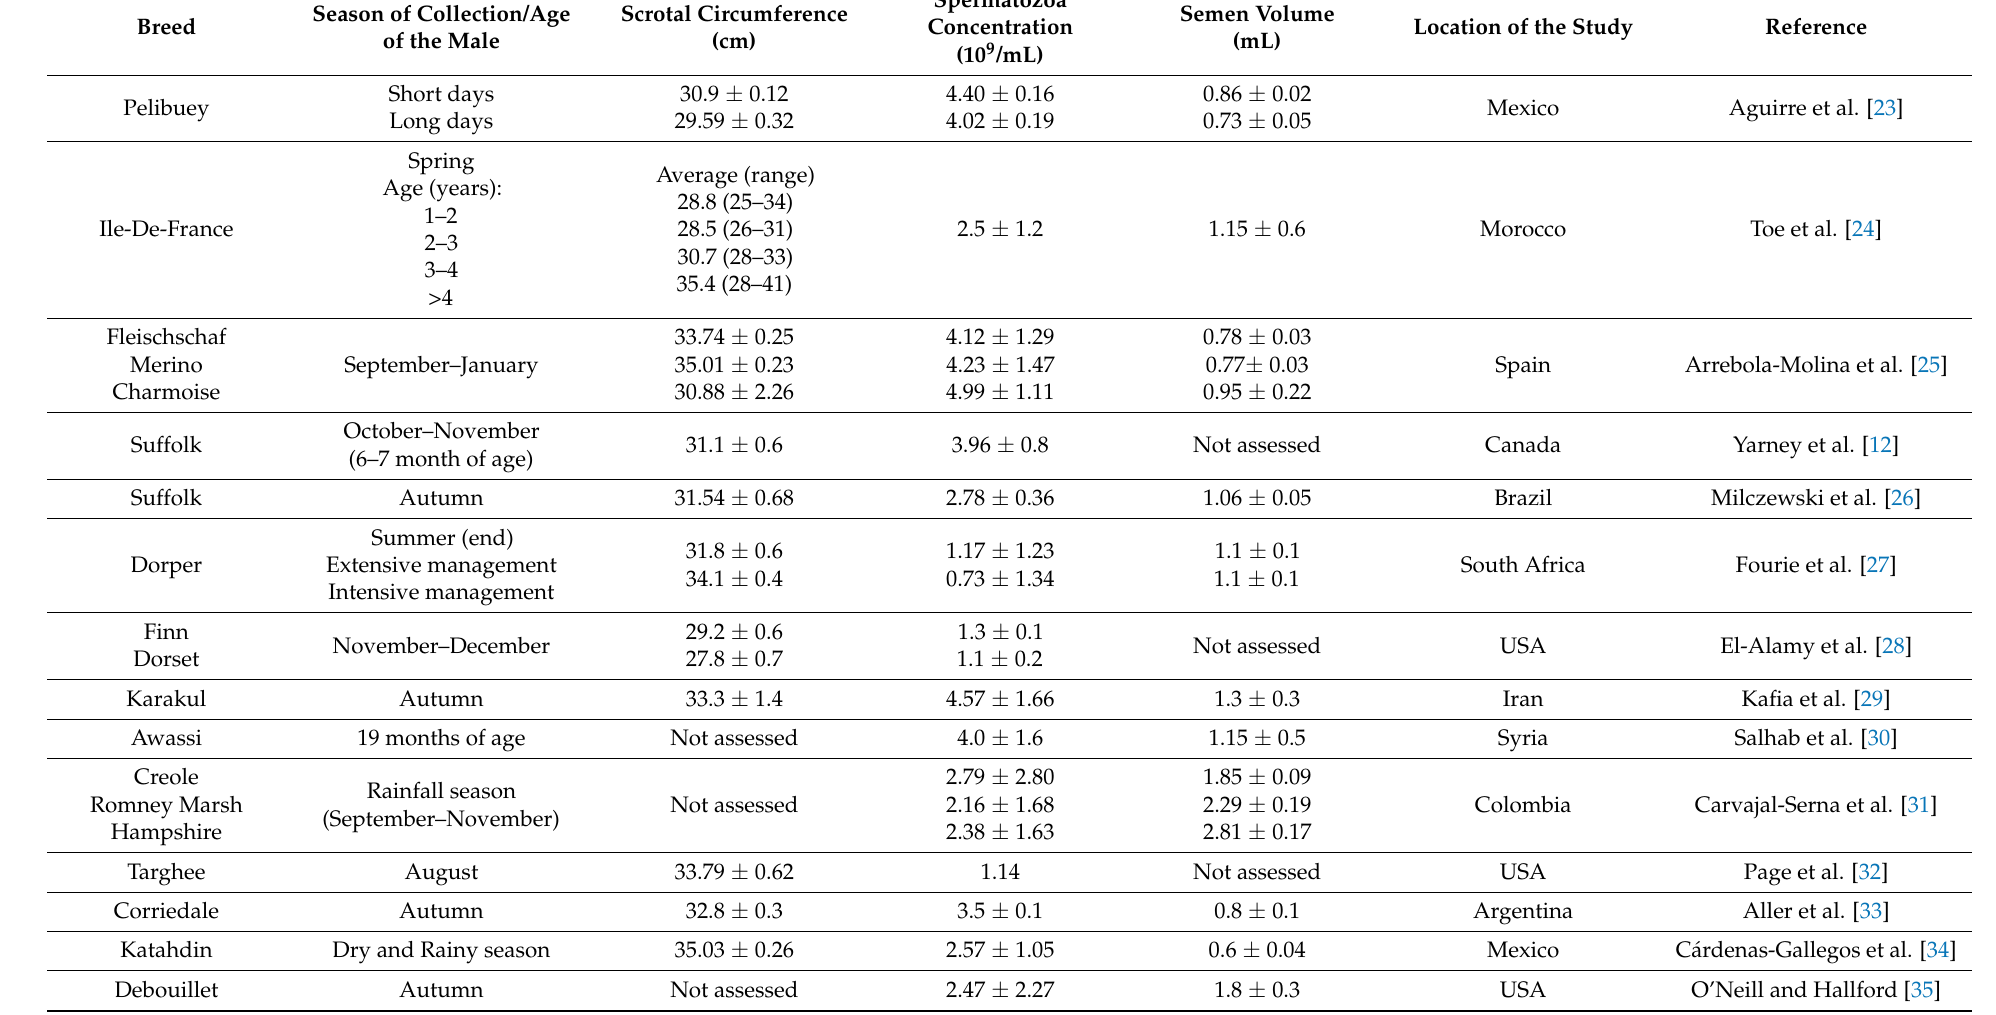
Table 1. Scrotal size and semen characteristics of different breeds of sheep across the world. Data presented in the table show values for pubertal rams.